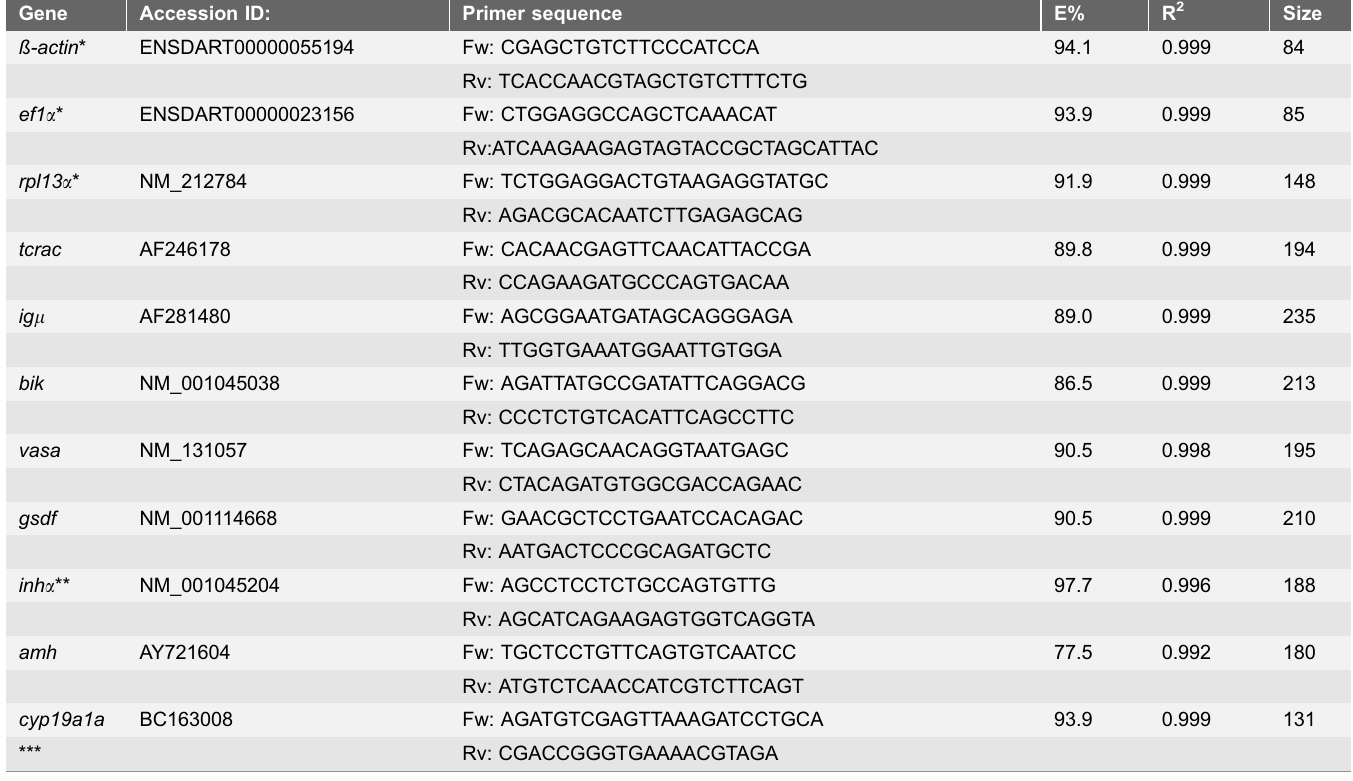
Table 6. PCR primers used for quantitative real-time PCR with primer efficiency (E%), co-efficient of determination (R 2 ), and amplicon size